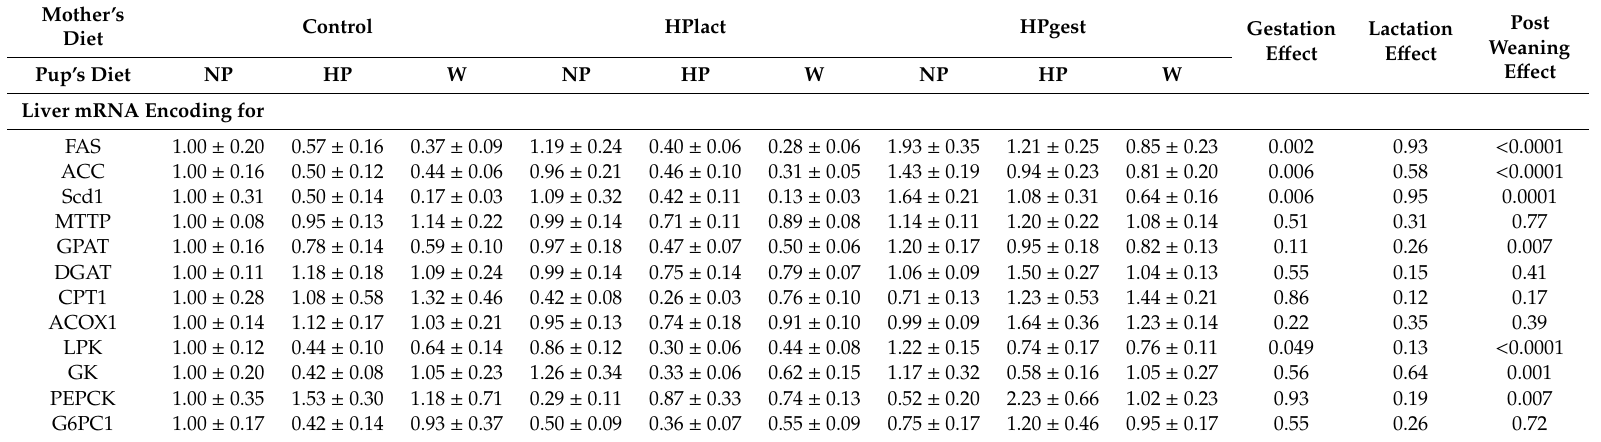
Table 2. Changes in mRNA encoding for genes in liver of fed female rat pups at